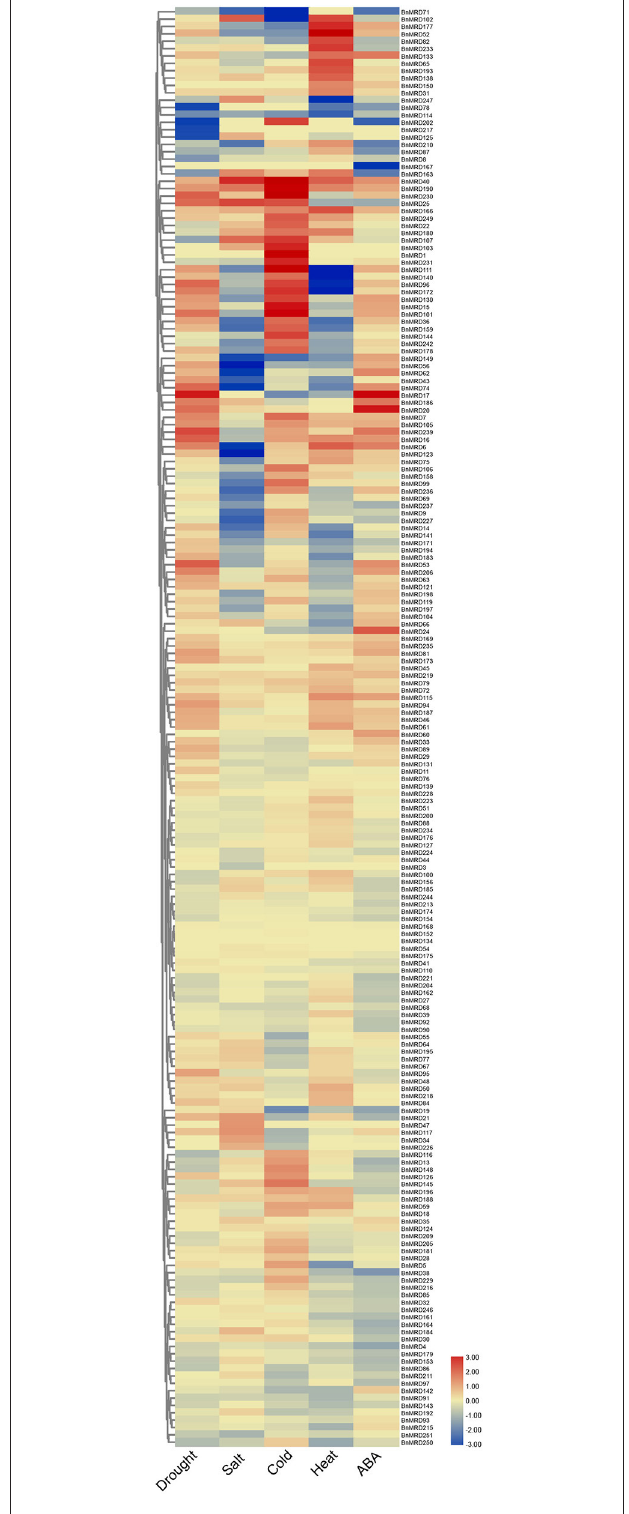
FIGURE 7 | BnMYB-related genes in response to four abiotic stress conditions (drought, salt, cold, and heat) and ABA treatment. Ratios of FPKM values under stress conditions to FPKM values under normal conditions are log 2 transformed and used to represent the gene expression